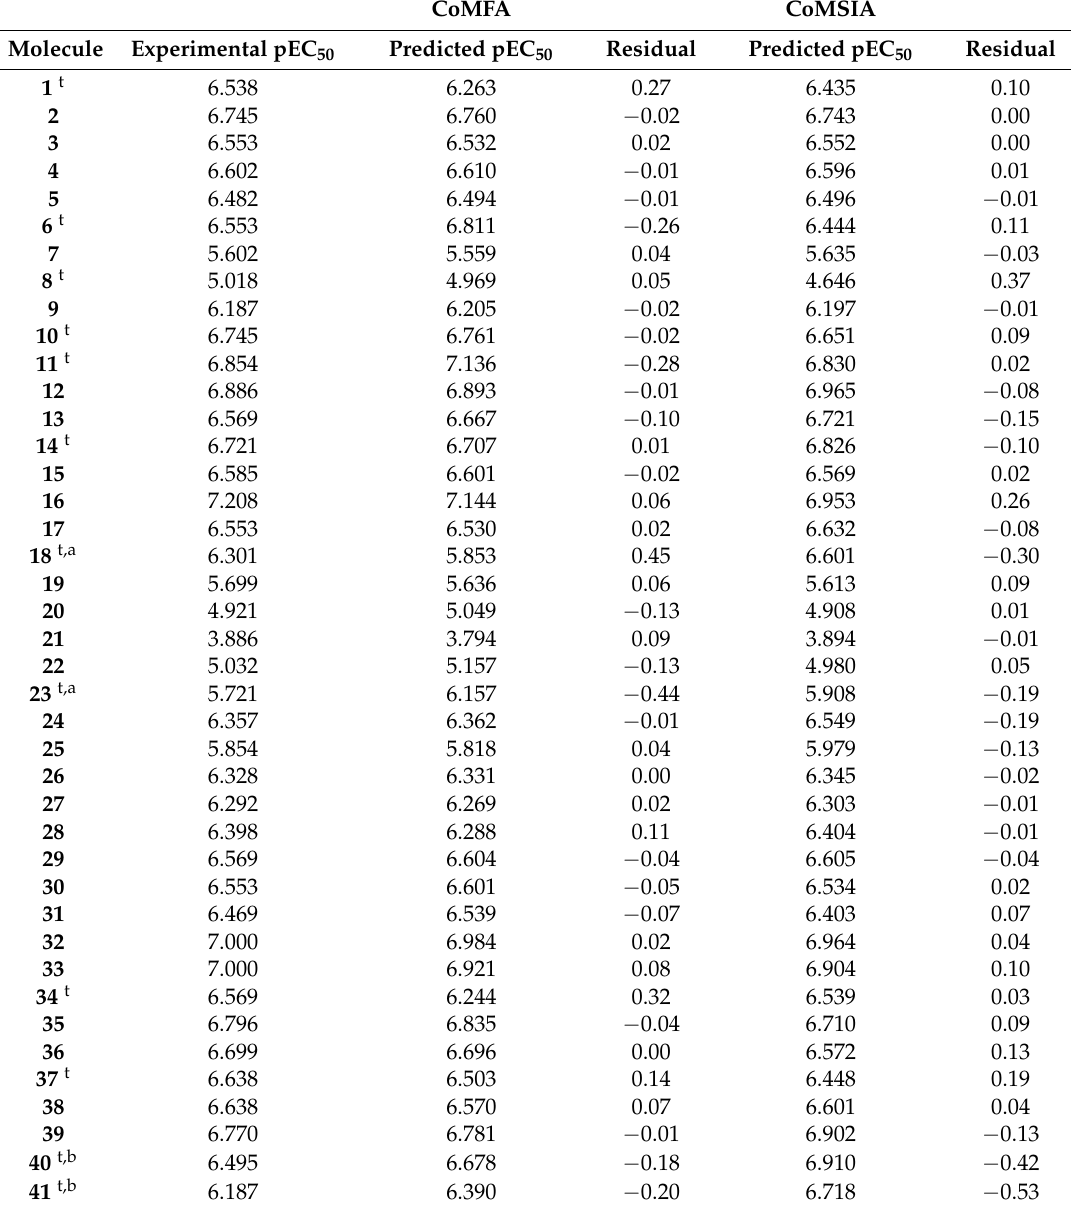
Table 3. Experimental and predicted pEC 50 and residual values for analyzed compounds according to CoMFA and CoMSIA. CoMFA CoMSIA Molecule Experimental pEC 50 Predicted pEC 50 Residual Predicted pEC